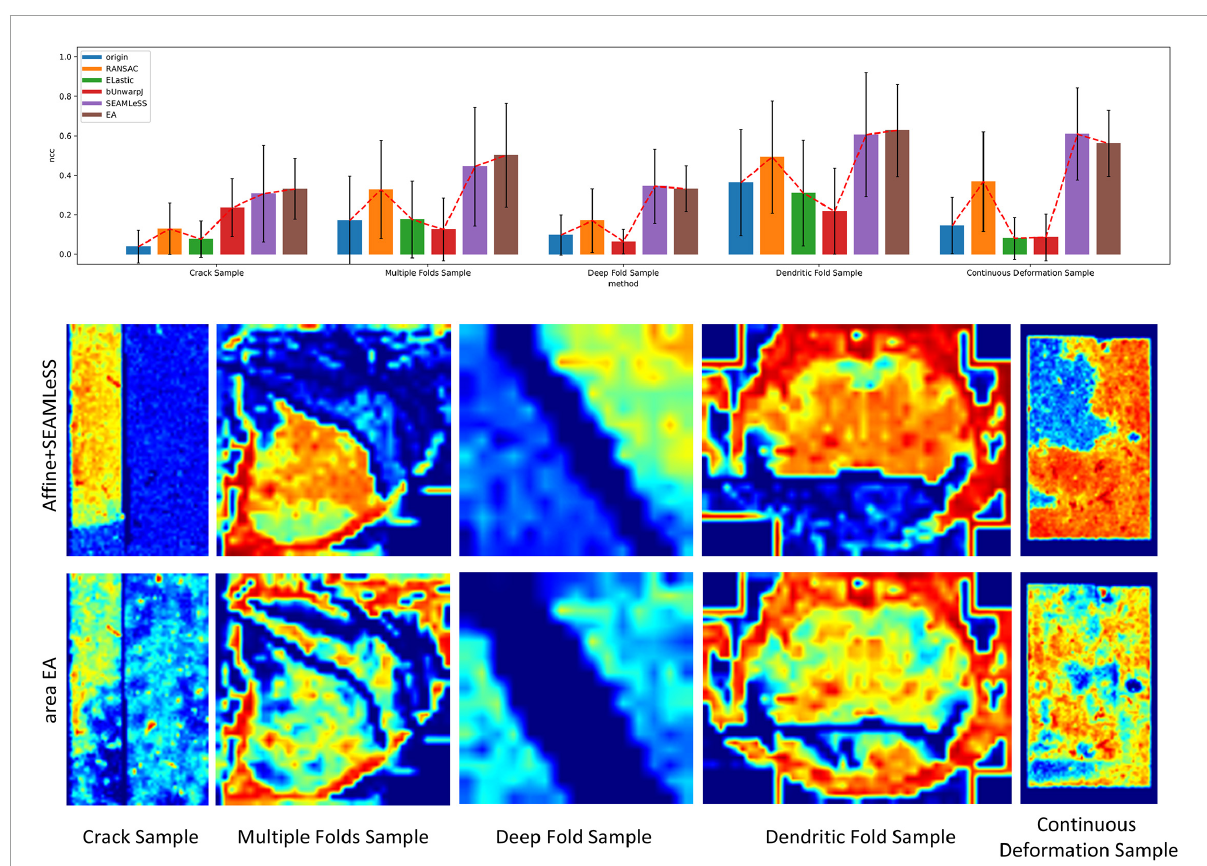
FIGURE5 The local patch normalized cross-correlation (NCC) of registration results. Up: Box plot of the mean of the local patch NCC distribution. Bottom: Heatmap of the NCC. The red indicates a high degree of similarity between the registered section and the reference section at the current position, whereas the blue indicates the